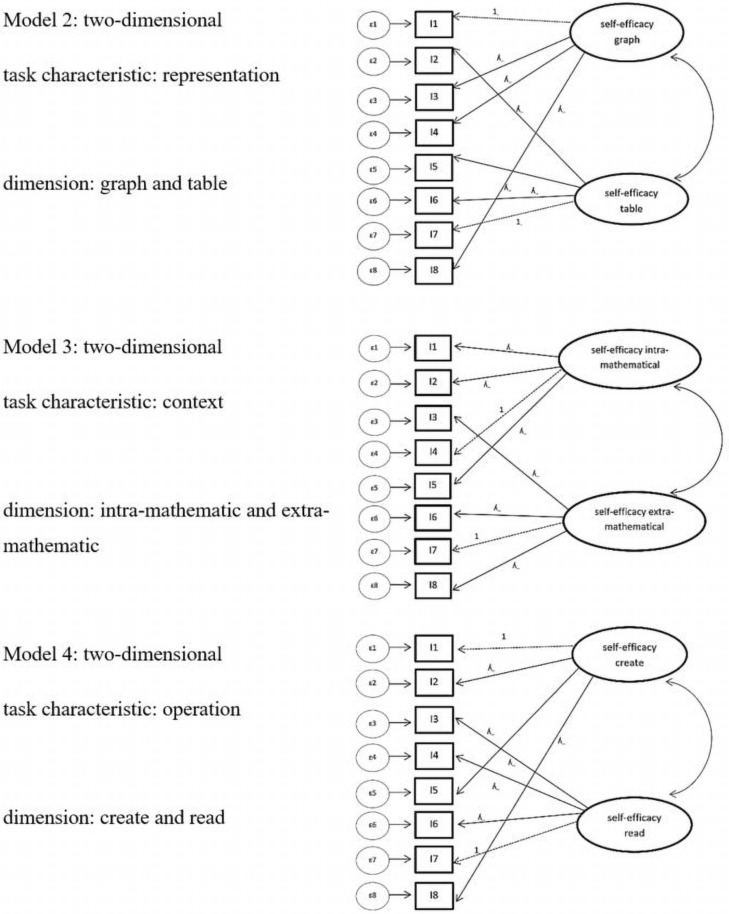
Model 2–4 task characteristic: Model of confirmatory factor analysis task characteristic differentiated in model 2: representation (graph or table), model 3: context (extra-mathematical or intra-mathematical), and model 4: operation (create and read). For simplification, only 8 items are shown. ε = error variances; λ = factor padding loading; I = item = task.